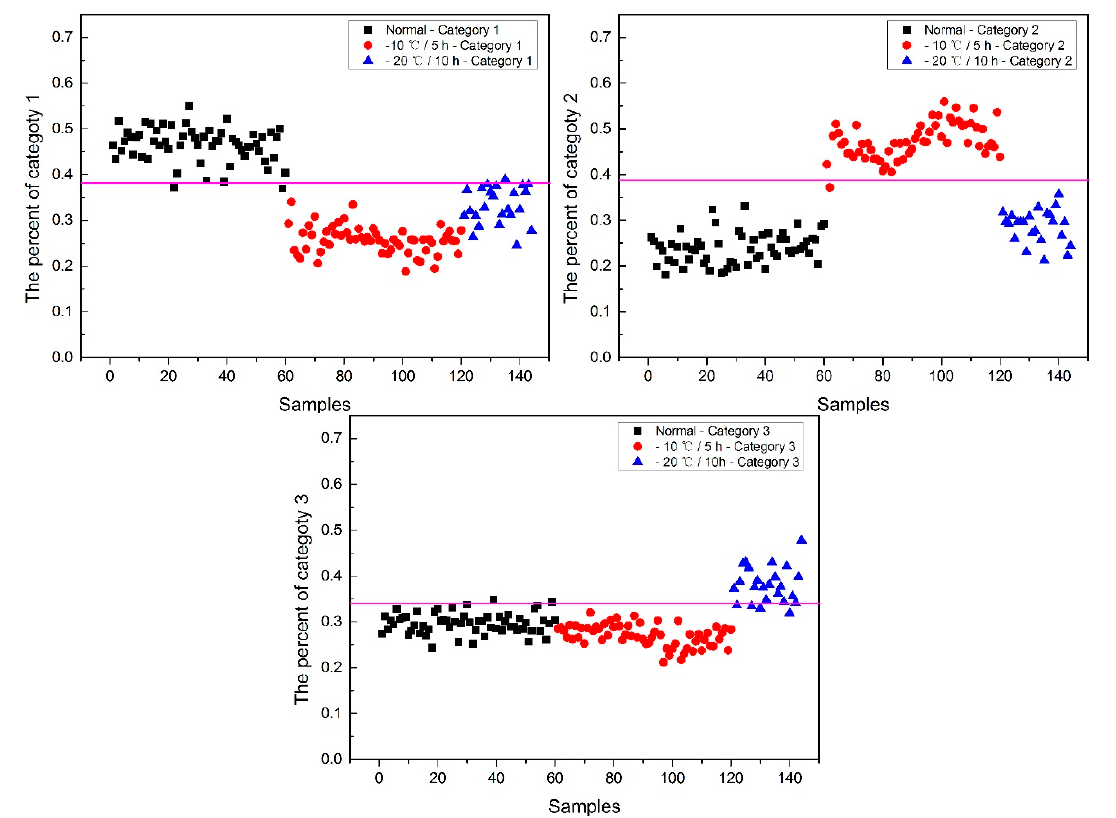
Figure 14. The percentage of each category of Jindan10 with the SPA and PLS-DA model.